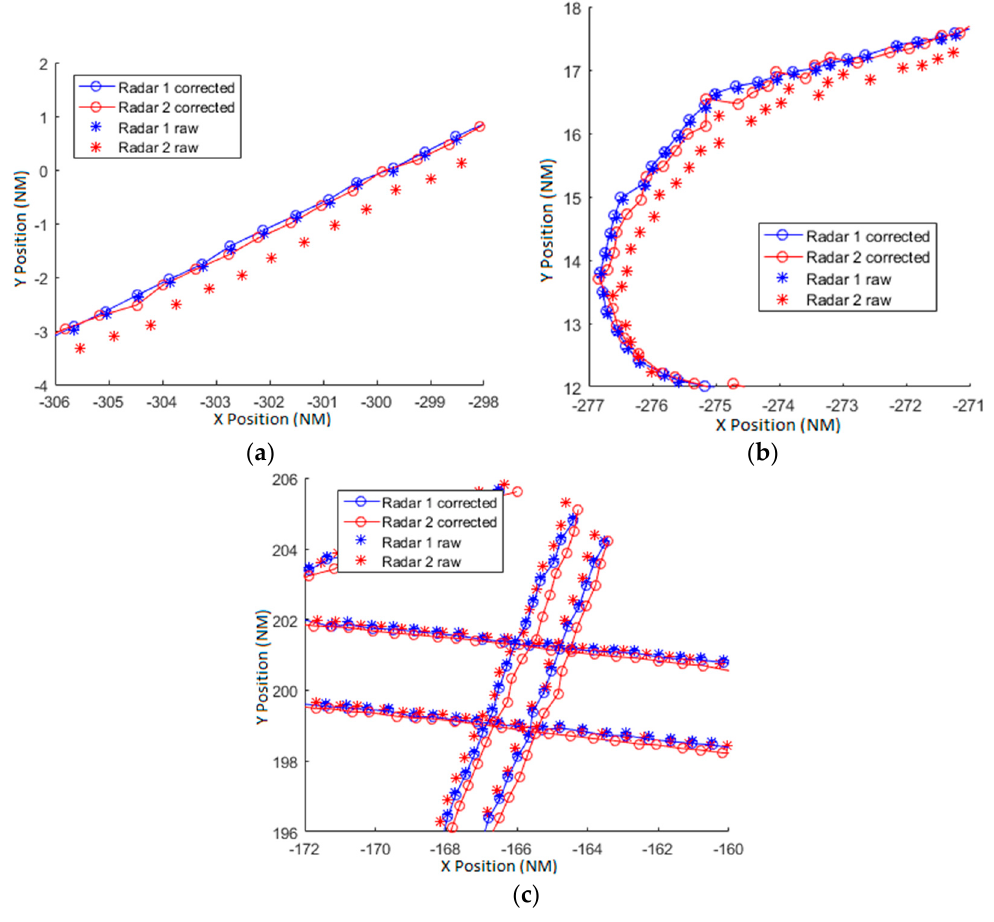
Figure 17 . ( a ) Straight trajectory; ( b ) Take off trajectory corrected with basic model; ( c ) Several trajectories allocated at the upper-right corner of the scenario corrected with the basic model.